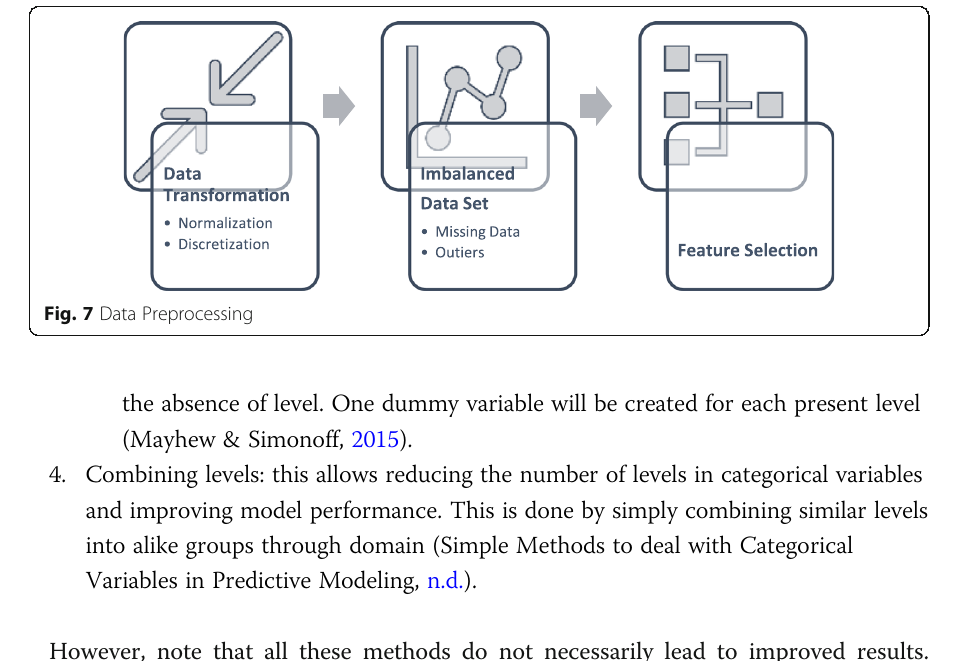
Table 11. recapitulates the various EDM application of preprocessing methods.